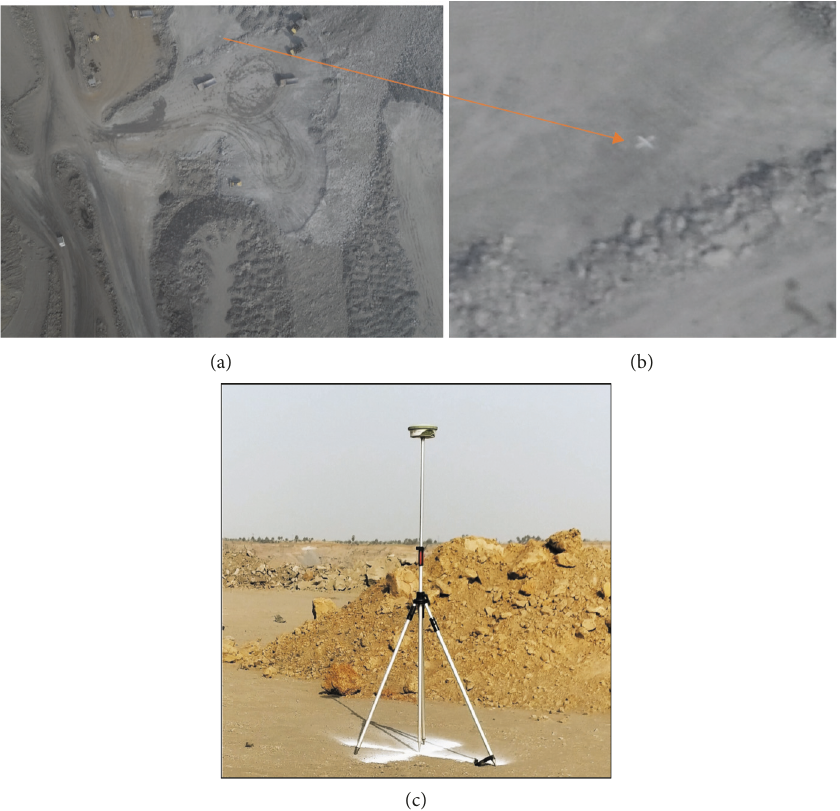
Figure 5: (a, b) represent temporary ground control point and (c) DGPS data acquisition for improving the accuracy of the UAV dataset.